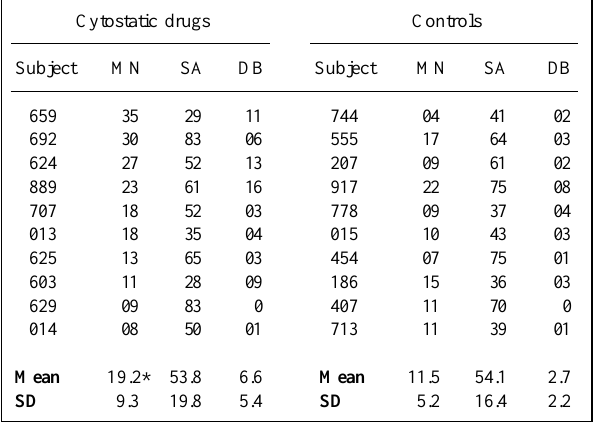
Table II - Frequency of binucleated lymphocytes with micronuclei (MN) and other nuclear anomalies in 2000 cells analyzed per hospital worker potentially exposed to cytostatic drugs, and their respective controls.